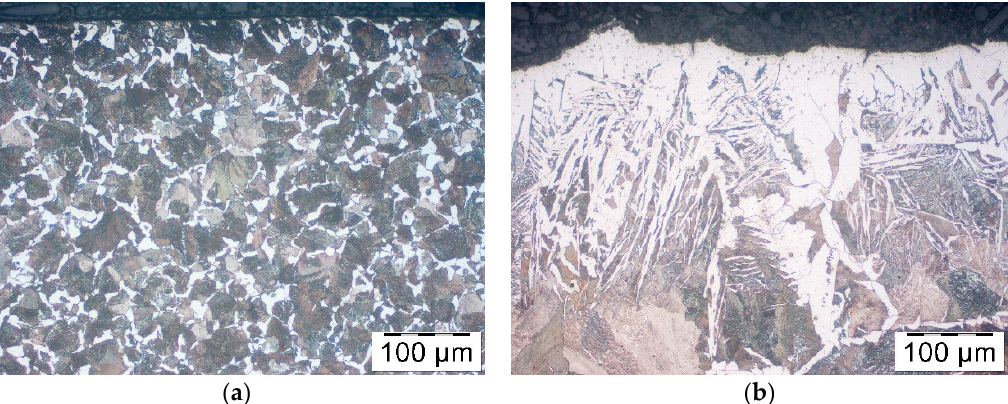
( d ) Figure 6. Microstructure of the surface layer of a steel bar C45 after induction heating, coated with Berulit—concentrations of ( a ) 100%, ( b ) 66%, ( c ) 50% and ( d ) 33%. Decarburization subsequent to Bonderite usage was observed- the concentration of the substance was 100%, 66% and 50%. Figure 7 shows the results. We may see that in this case, ferrite grains do not occur in high density by the top layer and do not penetrate deep into the bar, compared to the former product. We observe higher density when the con- centration of 50% is employed.